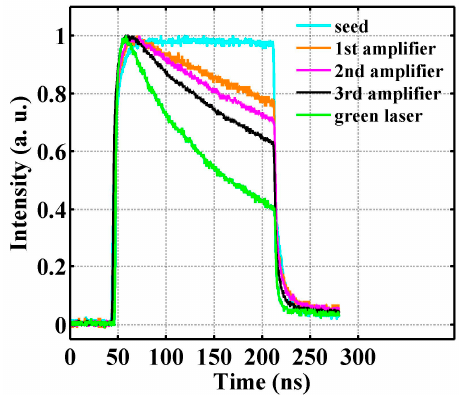
Figure 6. Pulse evolution for each amplifier.